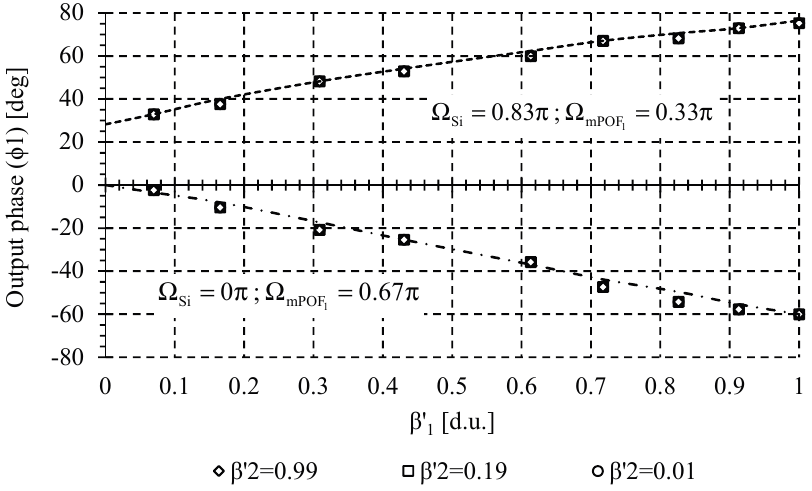
Figure 7. Crosstalk related measurements. Output phase parameter versus sensor loss at (FOS 1 ) for different values of sensor loss at channel λ channel λ (cid:2923)(cid:2900)(cid:2899)(cid:2890) (cid:2869)